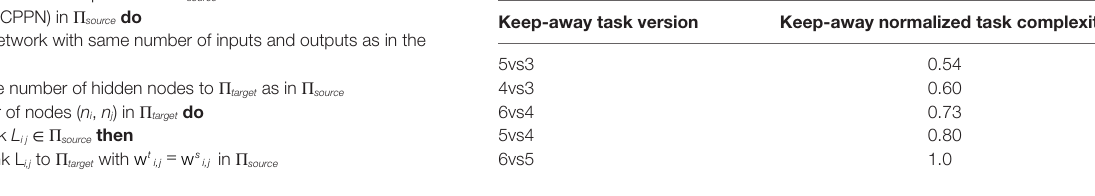
TaBle 4 | Normalized task complexity calculated for each keep-away